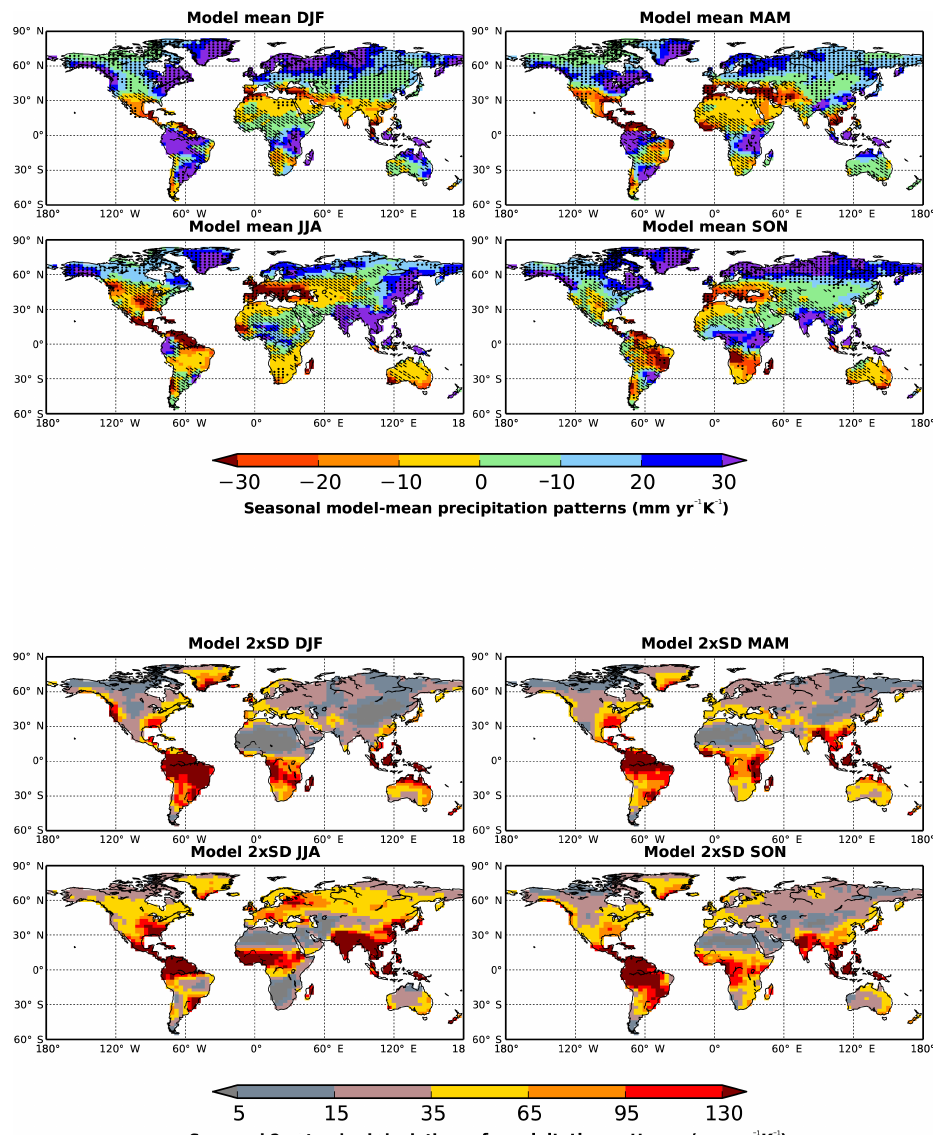
Figure 5. Seasonal means and variation (2 × SD) in the monthly patterns of local precipitation change per degree warming over all land (mmyr − 1 K − 1 ), across 22GCMs. In regions marked with stippling dots, more than 90% of the models agree in the sign of the change, whilst hatching is where less than 66% of the models agree in sign. DJF is December, January and February; MAM is March, April and May; JJA is June, July and August; and SON is September, October and